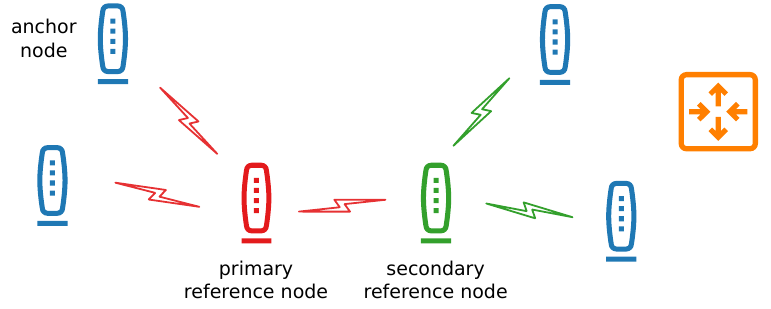
Figure 4. Transmission between the particular parts of the infrastructure during wireless synchronization procedure.